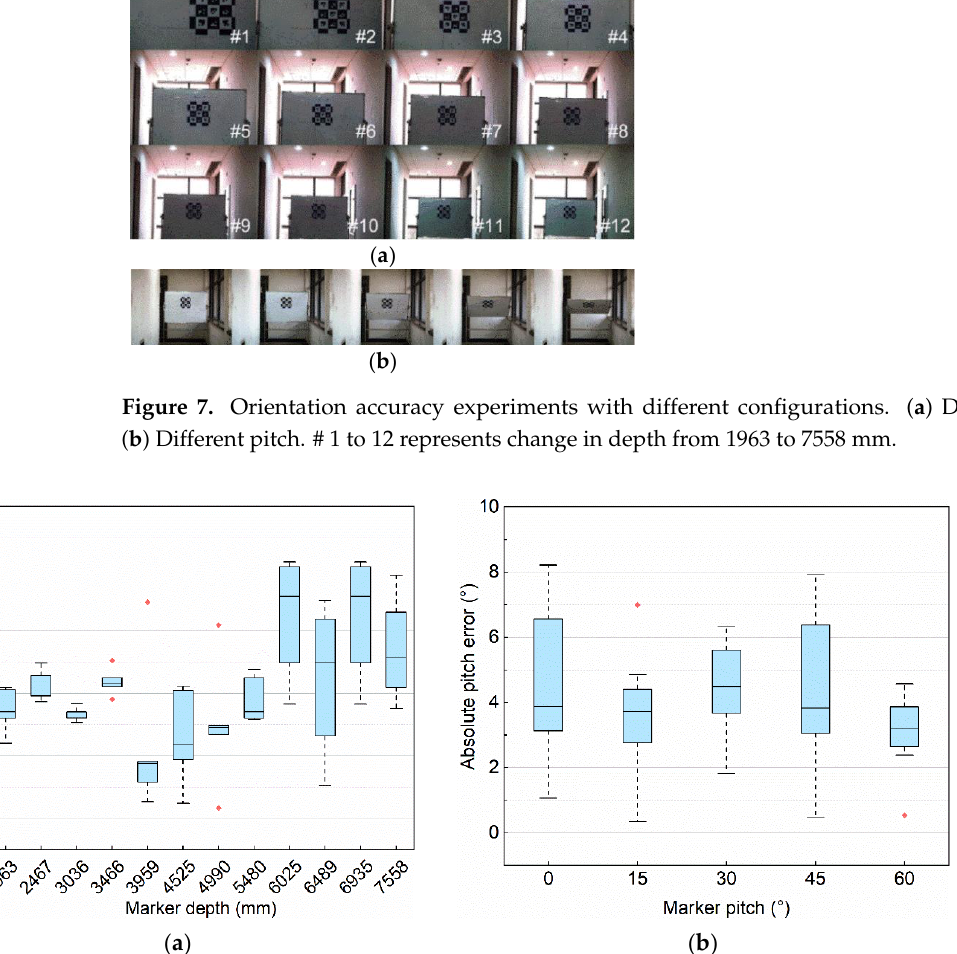
Figure 8. The absolute pitch error with different configurations. ( a ) Absolute pitch error under different marker depths. ( b ) Absolute pitch error under different marker pitches.